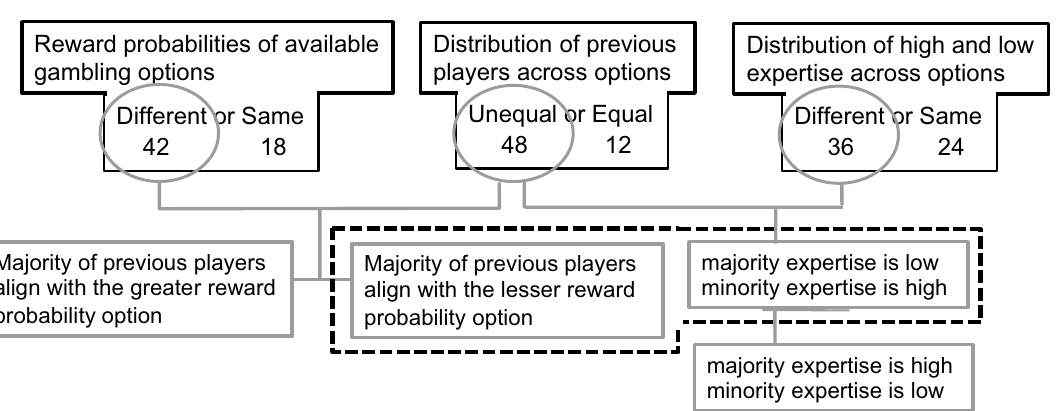
Figure 3. A graphical representation of the combination of variables of stakes, majority expertise and minority expertise into choice conditions, with one example condition shown encapsulated by the dotted boundary. All variables were manipulated within subject. Numbers indicate the total number of trials available at each level of each variable, from which subject-specific trials were subsequently drawn (see